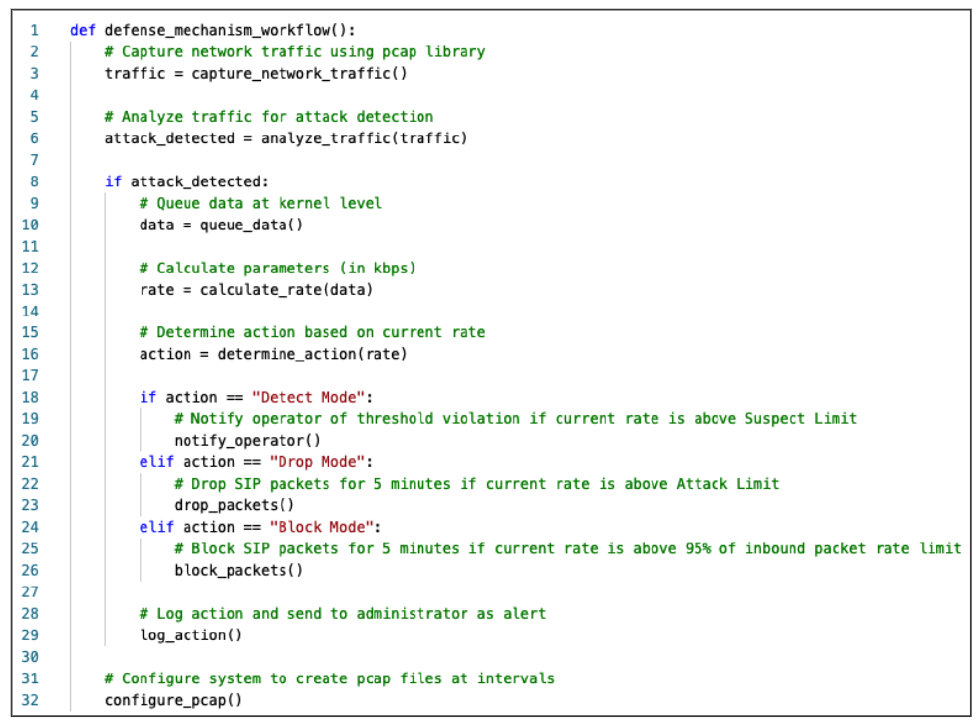
Figure 7. Pseudocode for the proposed defense mechanism using SIP-DD.